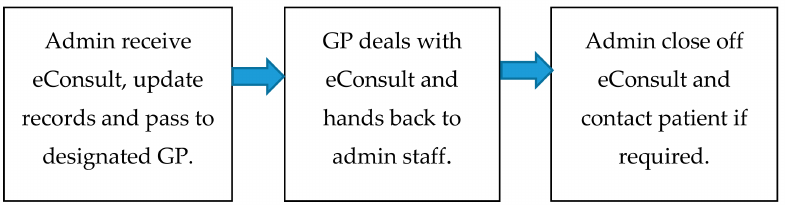
Figure 1. Simplified eConsult process.